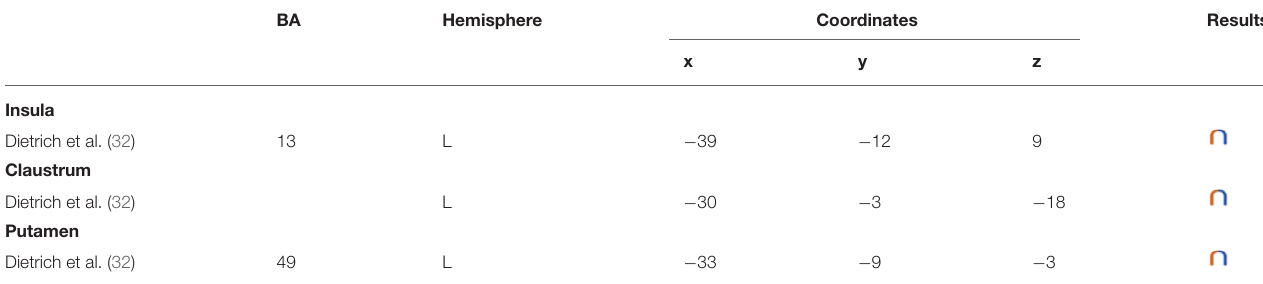
U-inverted symbols indicate increased neural activity in class I obese (BMI = 30) in comparison with lean participants, followed by a decrease for obesity classes II and III (BMI = 35–40), reaching similar levels of activation as lean participants. BA, Brodmann